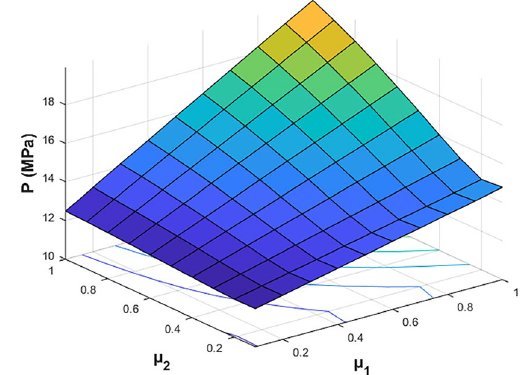
Fig. 20 Circumferential stress in the pipe, filler and sleeve at differ- ent elasticity modulus of the filler along radial centerline from inner layer of the pipe up to outer layer of the composite sleeve